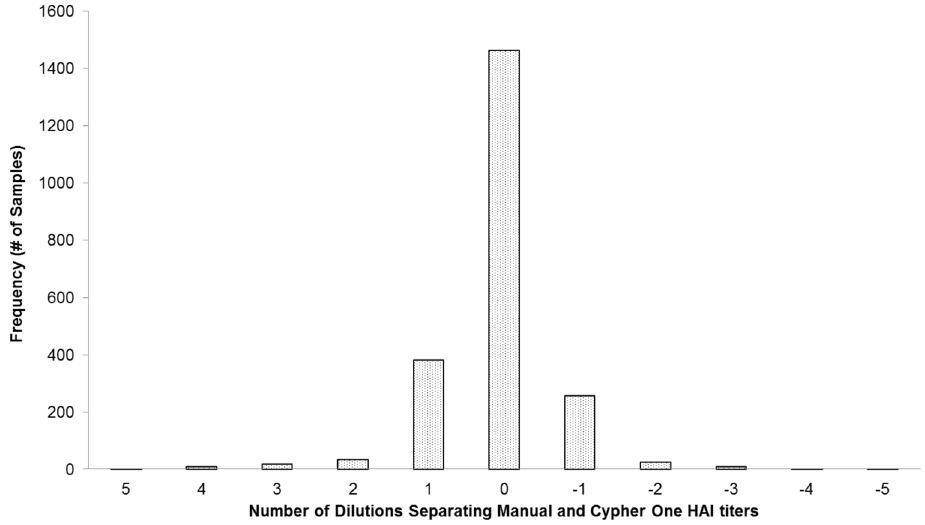
Fig 3. Histogram representing the number of dilutions different between the Cypher One and human titer interpretation for the entire dataset (n = 2200).